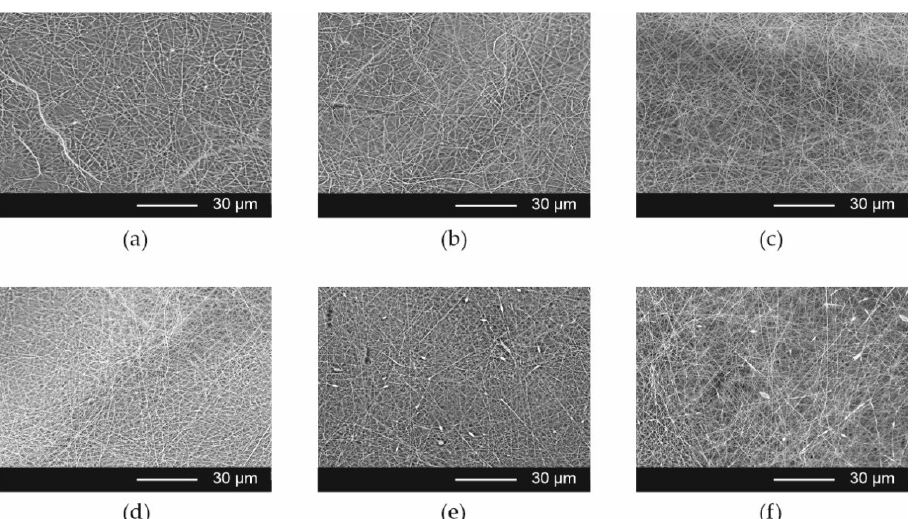
Figure 1. Scanning electron microscopic images of electrospun fibers (( a ) Esp ODF placebo; ( b ) Esp ODF 1; ( c ) Esp ODF 2; ( d ) Esp ODF 3; ( e ) Esp ODF 4; ( f ) Esp ODF 5; process parameters: 25 kV, 1.0 mL/h, 10 cm; magnification 2000 × ).